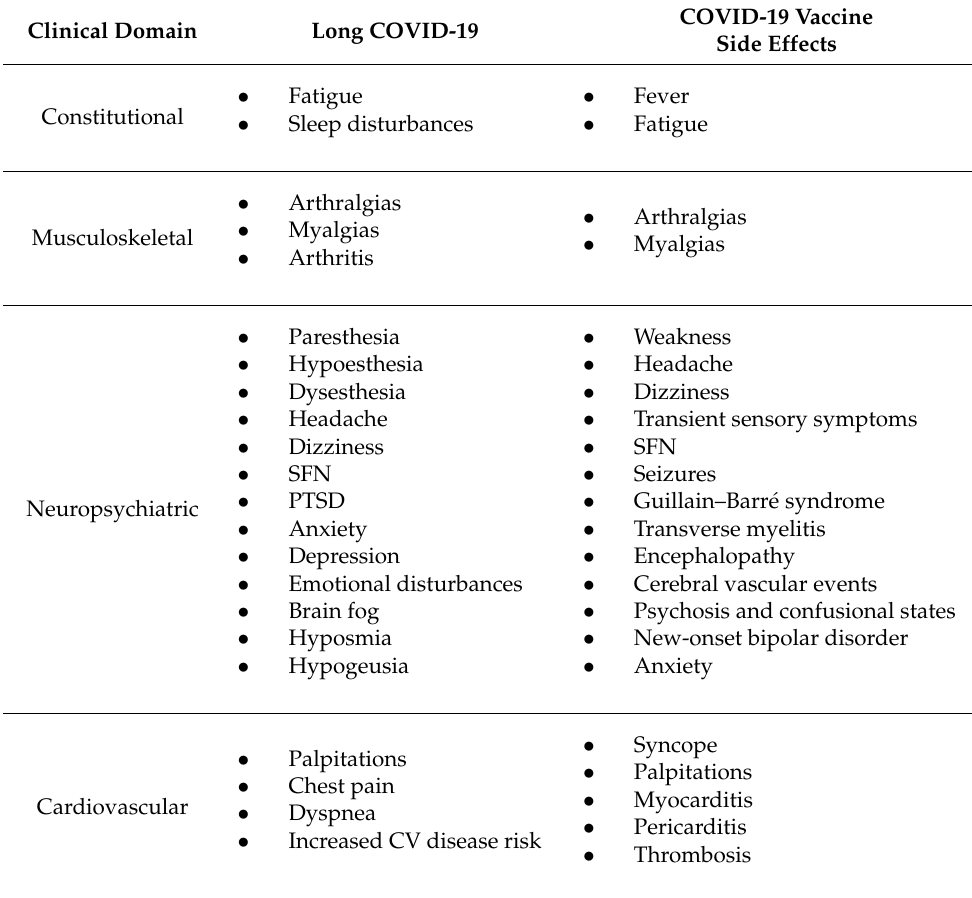
Table 4. Constitutional, musculoskeletal, neuropsychiatric, and cardiovascular manifestations re- ported during long COVID-19 or listed among the COVID-19 vaccine side